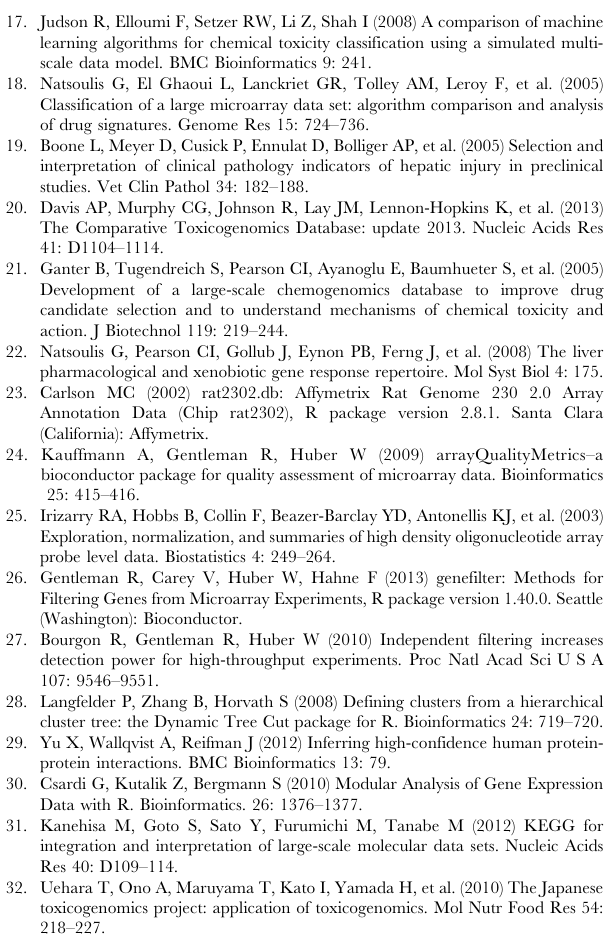
Table S1 The resultant log-ratio Z-score matrix con- taining 7, 826 genes by 640 conditions. Table S2 ISA determined gene co-expression modules and their gene membership.